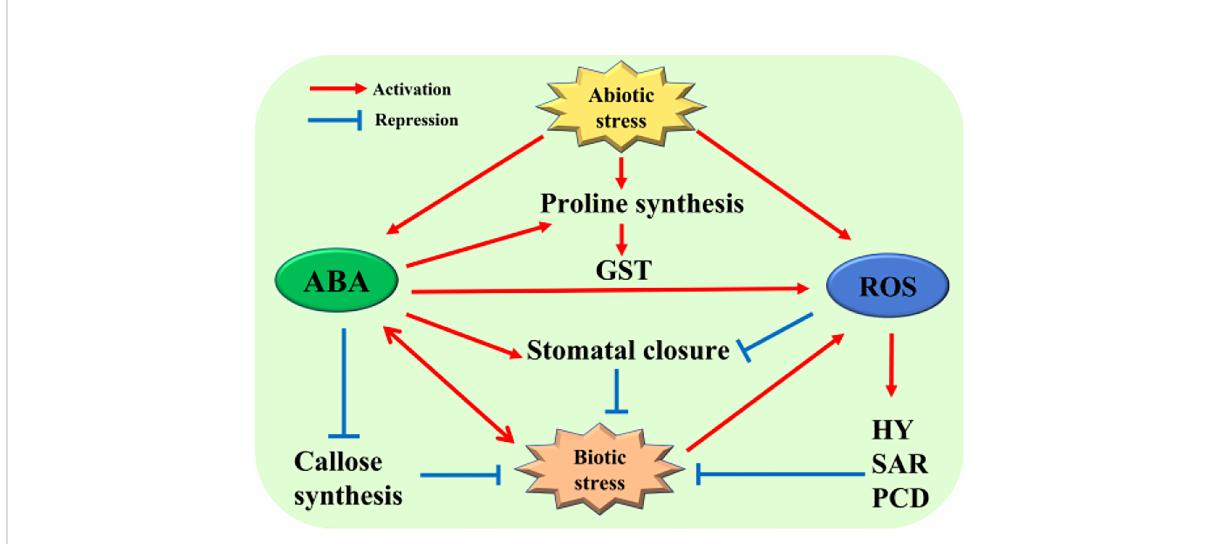
FIGURE 1 Regulatory network of the plant response to stress between ABA and ROS. Both biotic and abiotic stresses can cause the accumulation of ABA and ROS in plants, and ABA and ROS can also inhibit or adapt to external stress by regulating the content of some substances in plants or regulating the defense response of plants to maintain normal growth and development. For detailed explanation, please see